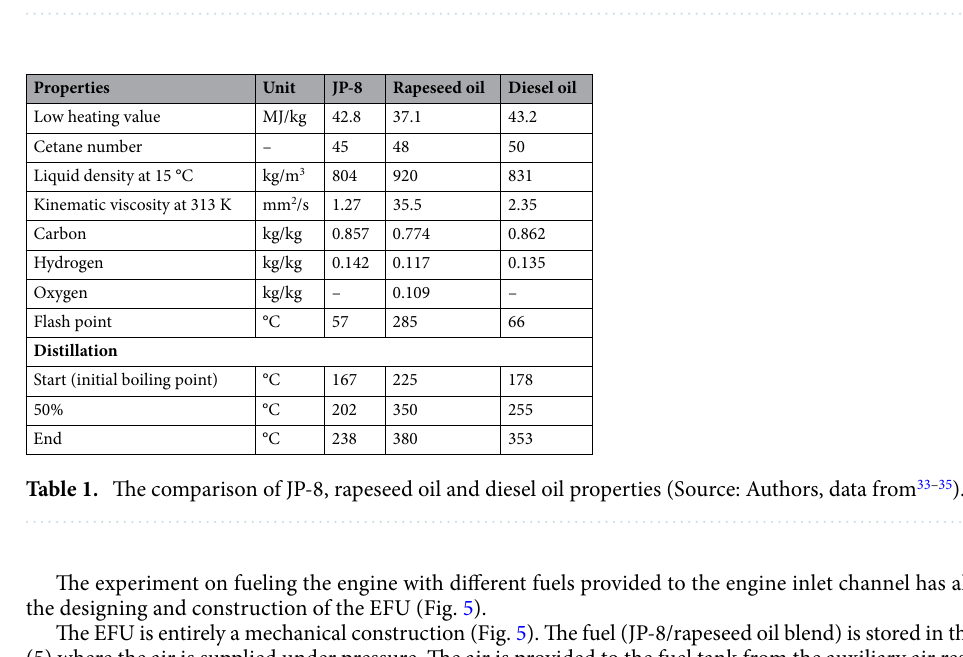
Figure 2. Cylinder pressure diagrams ( a ), and the rate of heat release ( b ) for engine fueling with JP-8 without mixture dilution (curves no. 1, 2, 3, 4) and with dilution using CO 2 (curves no. 5, 6, 7) for the mixture created outside engine cylinder, n = 1200 rpm. Curve number: 1—JP-8 (λ = 1.76, BMEP = 2.5 bar, η th = 22.2%, dp/ dα = 12.6 bar/deg), 2—JP-8 (λ = 2.00, BMEP = 2.3 bar, η th = 23.4%, dp/dα = 10.9 bar/deg), 3—JP-8 (λ = 2.04, BMEP = 2.8 bar, η th = 38.1%, dp/dα = 11.8 bar/deg), 4—JP-8 (λ = 2.14, BMEP = 2.5 bar, η th = 39.1%, dp/ dα = 8.0 bar/deg), 5—JP-8, 10% CO 2 (λ = 1.85, BMEP = 2.8 bar, η th = 24.1%, dp/dα = 7.3 bar/deg), 6—JP-8, 15% CO 2 (λ = 1.46, BMEP = 3.6 bar, η th = 21.0%, dp/dα = 7.8 bar/deg), 7—JP-8, 20% CO 2 (λ = 1.26, BMEP = 4.1 bar, η th = 19.8%, dp/dα = 7.5 bar/deg). (Source: Authors).